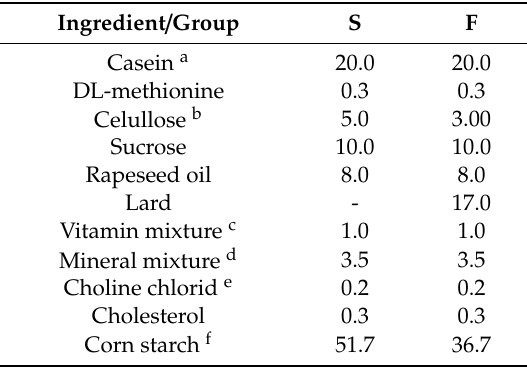
Table 1. Composition of diets fed to rats,